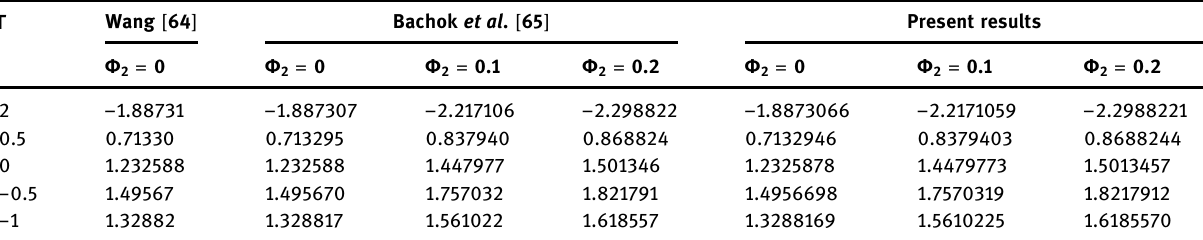
Table 4: Numerical values of